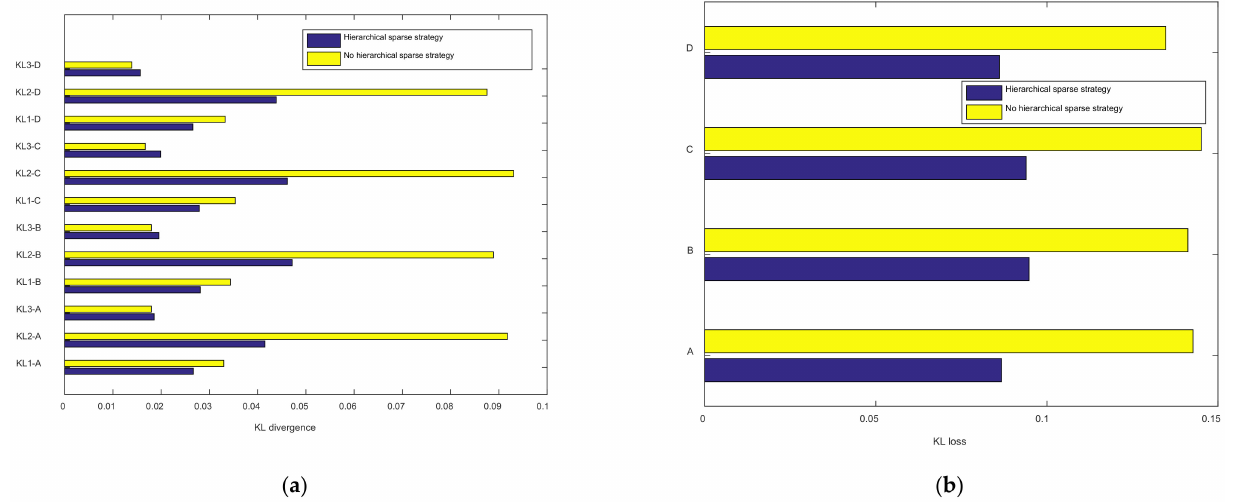
Figure 8. The effect of hierarchical sparsity strategy on network sparsity. ( a ) KL divergence of neurons in each layer of different data sets; ( b ) KL divergence total loss for different data